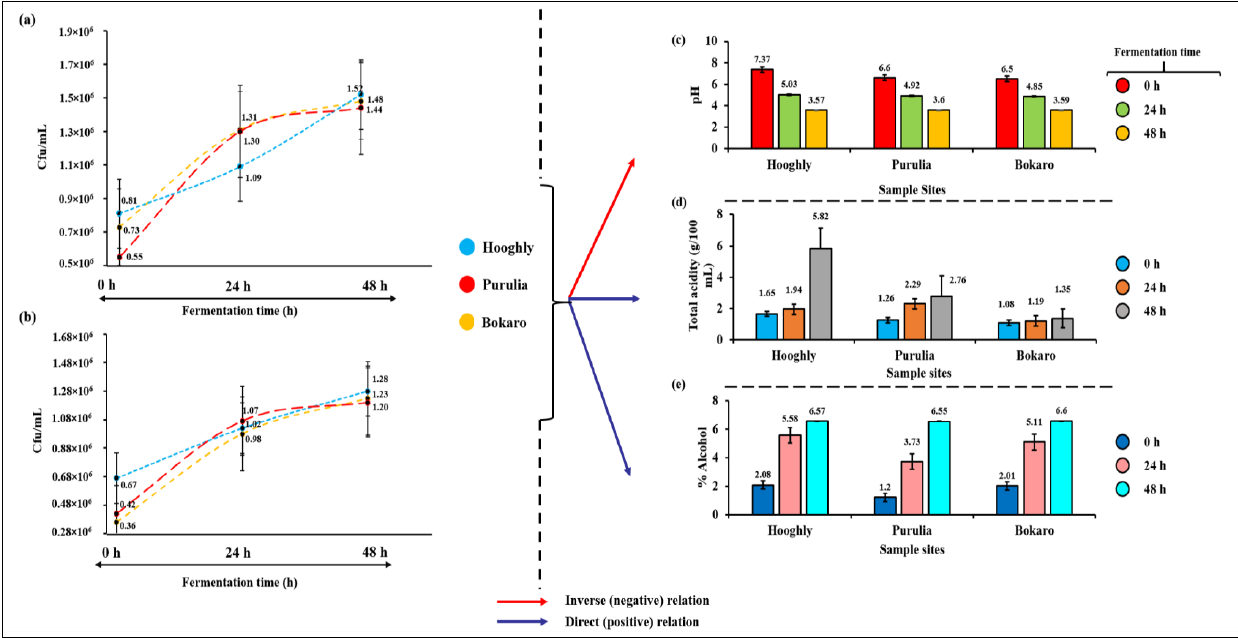
Figure 2. Successional changes in total microbial load and different physico-chemical parameters during the fermentation of toddy : ( a ) total bacterial load, ( b ) total load of yeasts, ( c ) pH, ( d ) total acidity content and ( e ) total alcohol content (error bar is representing SD).